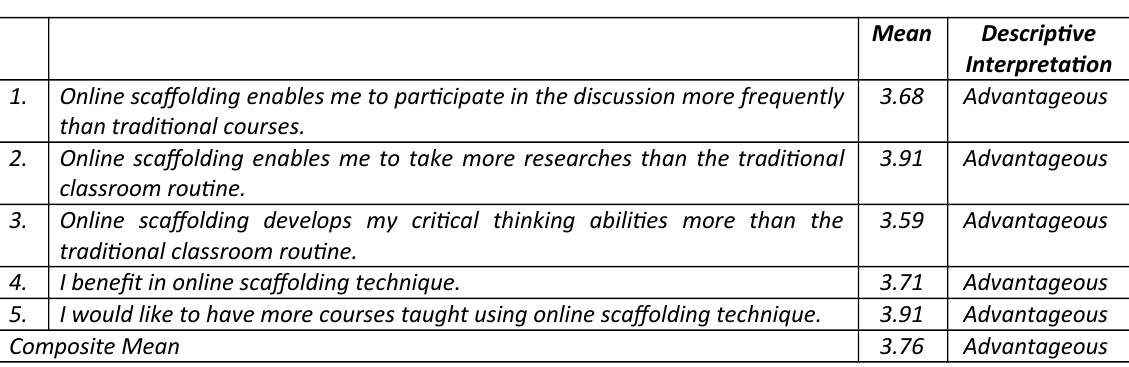
Table 5. The Perceived Magnitude of Advantages of the Online Scaffolding of Teaching and